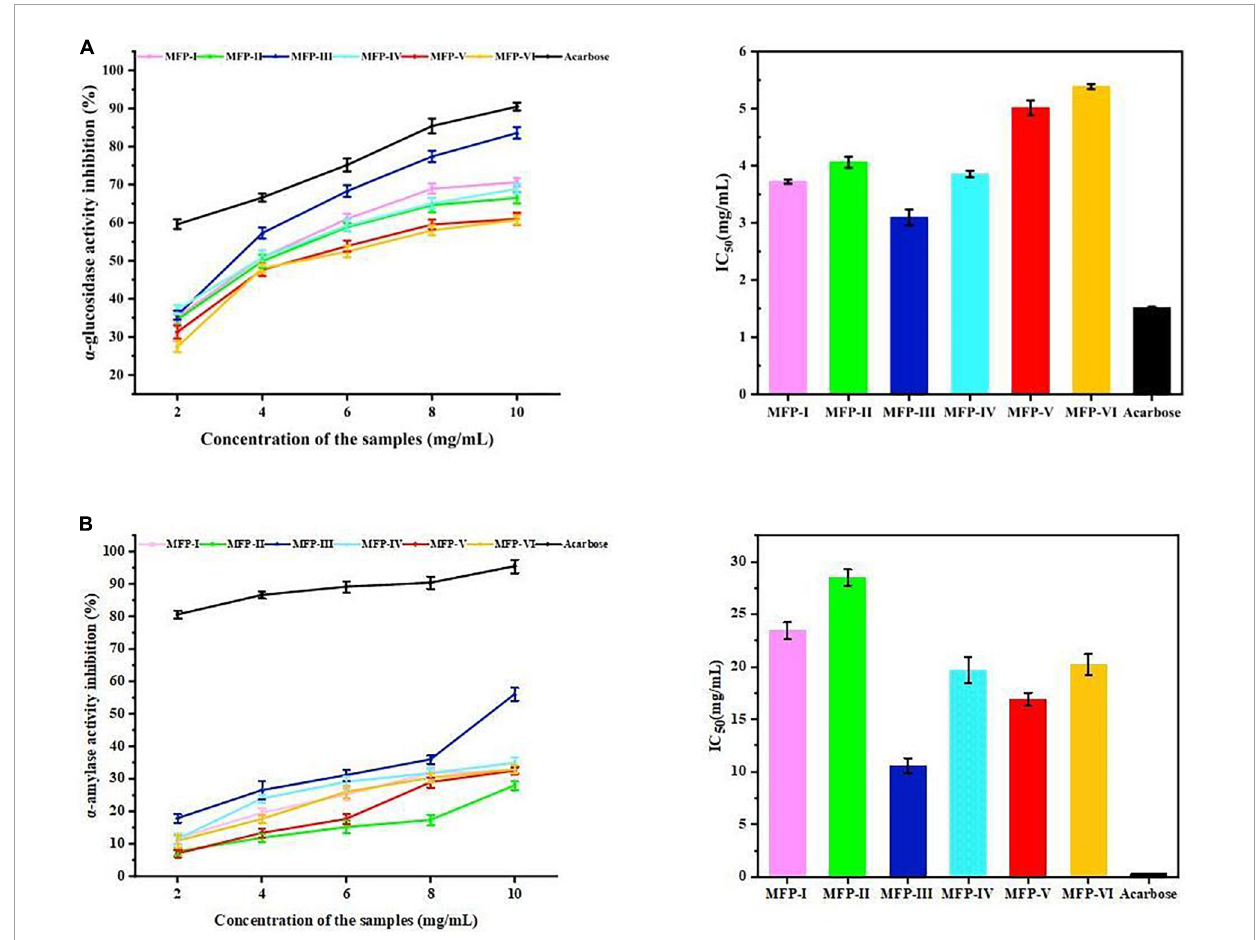
FIGURE10 Hypoglycemic effects of MFP in vitro : (A) inhibitory effect on α -glucosidase; (B) inhibitory effect on α -amylase